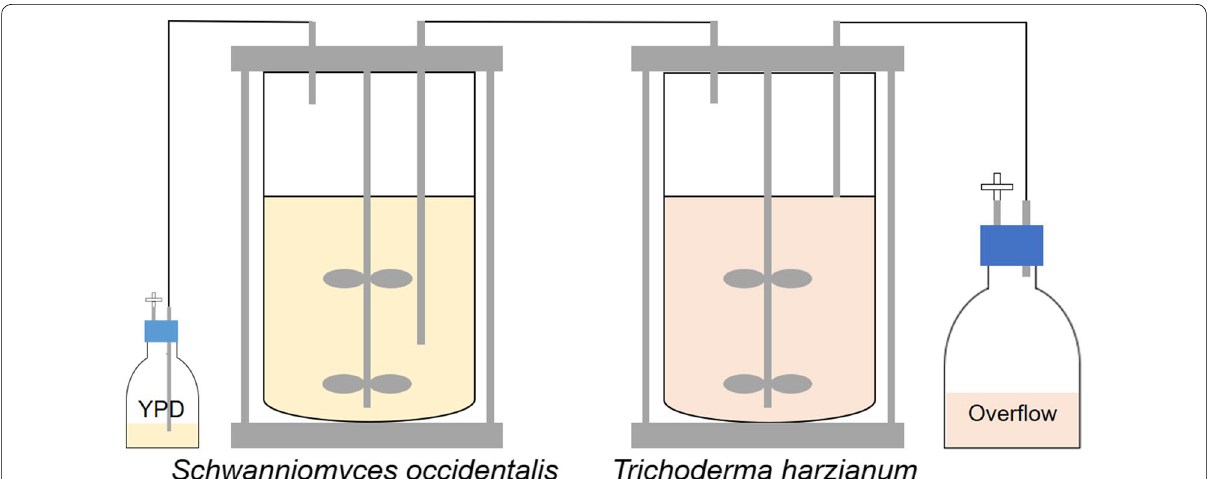
Fig. 1 Experimental setup of the double continuous cultivation of the TMEs. Schematic overview of the production of tailor-made enzymes (TMEs) using a double continuous fermentation. In the first bioreactor Schwanniomyces occidentalis is continuously grown on YPD medium. In the second bioreactor Trichoderma harzianum is fed with living S. occidentalis . In this way T. harzianum will start producing TMEs against S. occidentalis . At the end of the cultivation, the T. harzianum broth is harvested and the supernatant separated from the biomass. This supernatant is used as the TME cocktail in further experiments